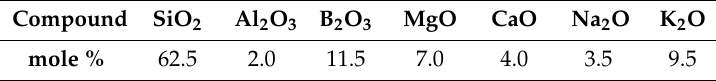
Table 2. Chemical compositions of glass